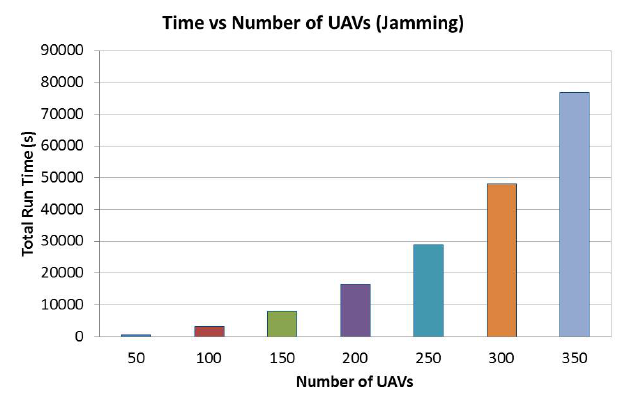
Figure 9. Run time variation with GUI and Non-GUI